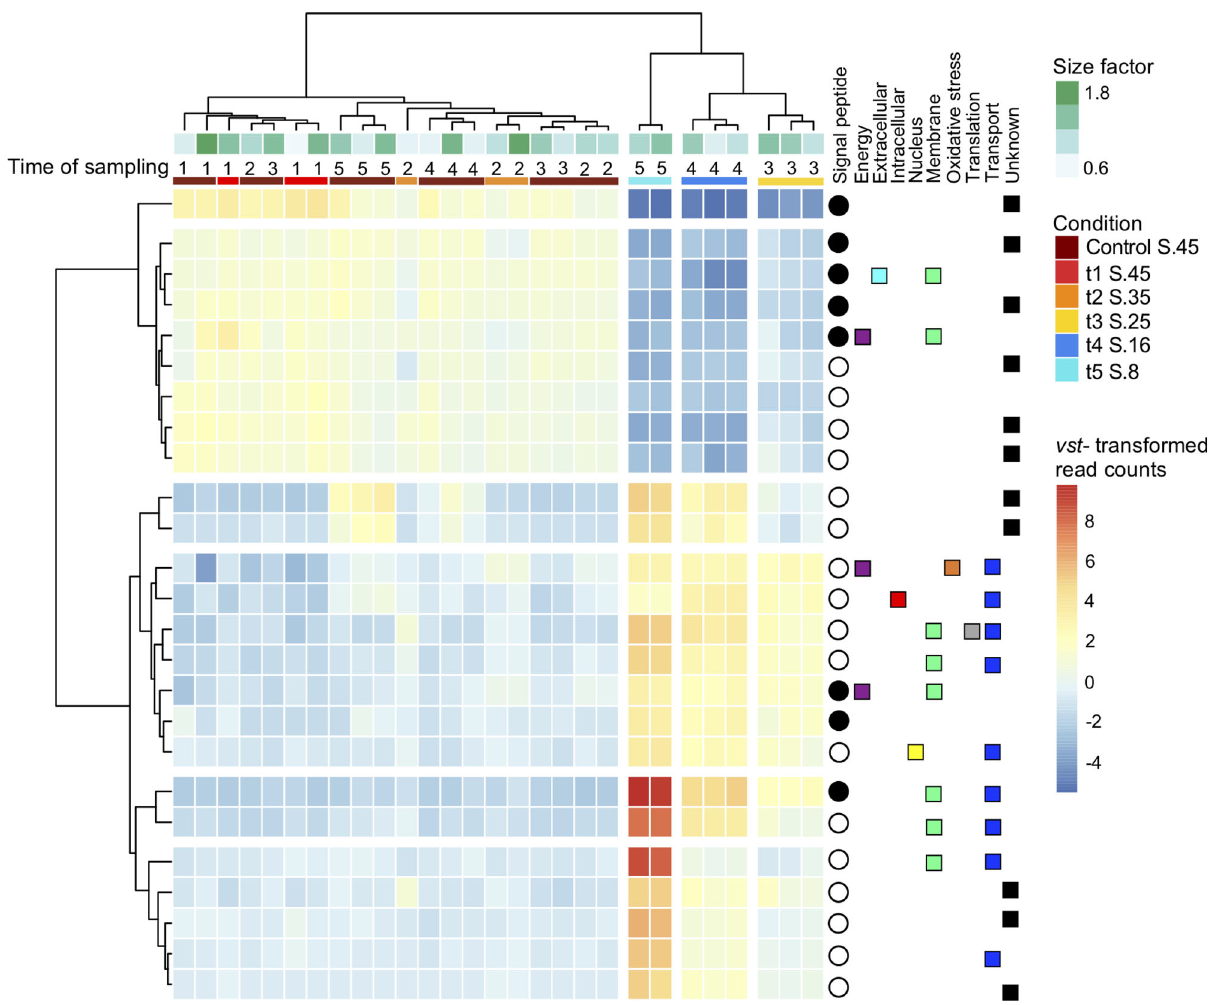
Fig. 2 Top 25 genes with the most variant expression. Heatmap of clustered results based on normalized and transformed read counts with vst() function in DESeq2 package on R. Size factor (greens) correspond to the sequencing depths of each transcriptome. Condition (bars beneath time of sampling) corresponds to salinity treatment, control condition is S.45, the number above is the sampling time. The annotation of each gene is on the right, indicated by squares, with each category having a separate color. Unknown function genes are in black. Genes with signal peptides shown with fi lled circle, the empty circle indicates no signal peptide was found. Note that the lowest salinity (S.8, aqua bar) is arranged between the higher and mid